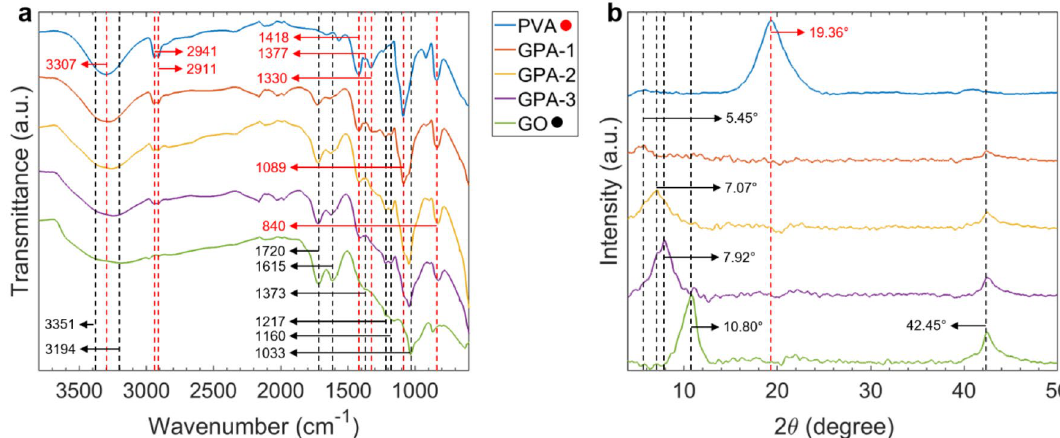
Figure 3. Physicochemical characterisation of GO/PVA aerogels: ( a ) FT-IR spectra and ( b ) XRD patterns. Wavenumbers attributable to GO are denoted in black while those for PVA are in